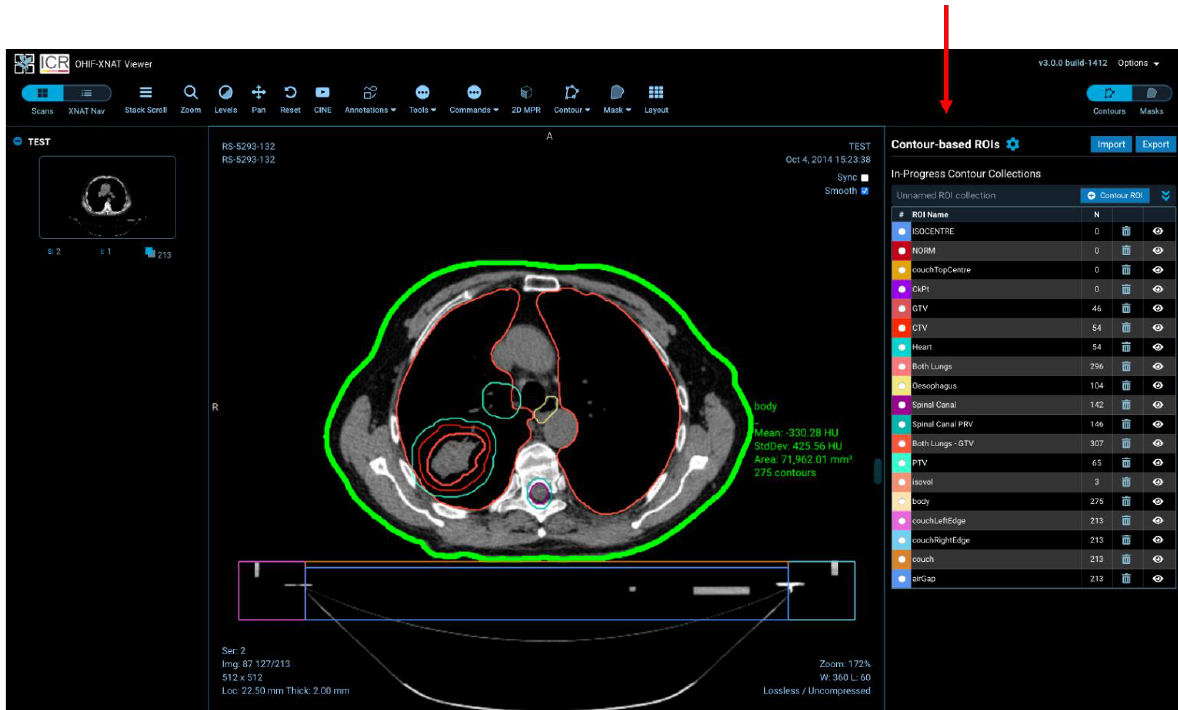
Figure 2. Visualisation of an RT Structure Set within the ICR-XNAT-OHIF viewer, also demonstrating the contour sidebar component developed as part of this project.